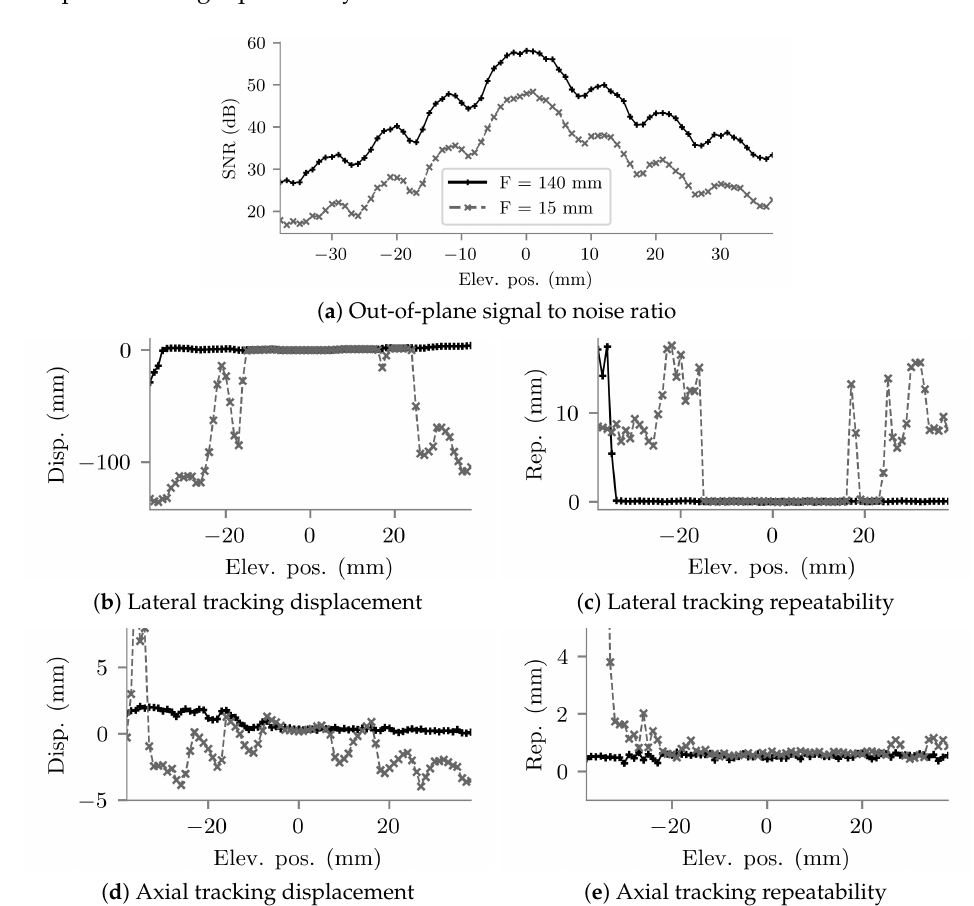
Figure 10. Results of the out-of-plane tracking accuracy assessment. The legend shown in ( a ) applies to all five plots. Measurements were made with two US imaging system focal depths: 140mm and 15mm. The needle tip was located 145mm from the centre of the probe face in the axial direction. ( a ) Out of plane signal-to-noise ratio. ( b ) Difference between tracked and true lateral positions. ( c ) Standard deviations of the repeat measurements of lateral position. ( d ) Difference between tracked and true axial positions. ( e ) Standard deviations of the repeat measurements of axial